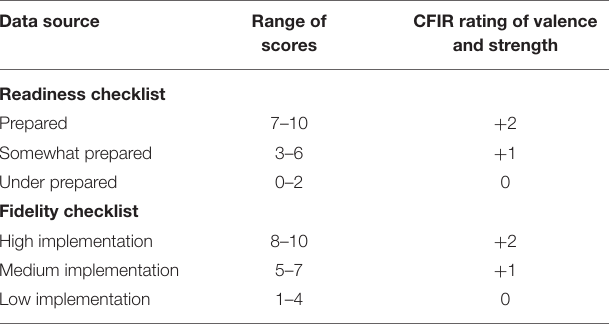
TABLE 3 | Readiness and fidelity checklist scores and the related CFIR rating of valence and